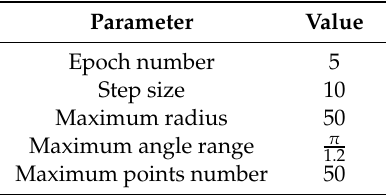
Table 2. The parameters of RS-based methods.